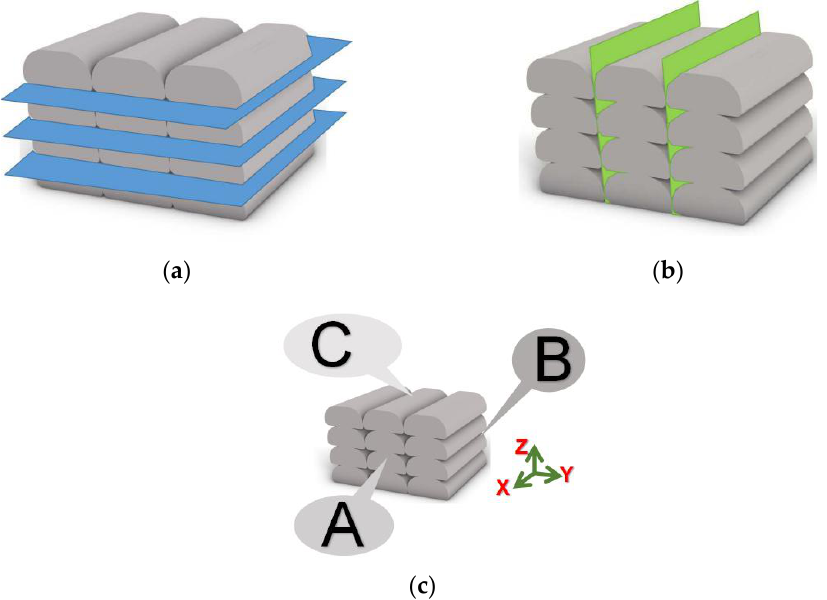
Figure 13. The horizontal interlayer diagrammatic sketch between printing layers ( a ), the vertical interlayer diagrammatic sketch between printing filaments ( b ), and the diagrammatic sketch of printed cube sample faces ( c ).